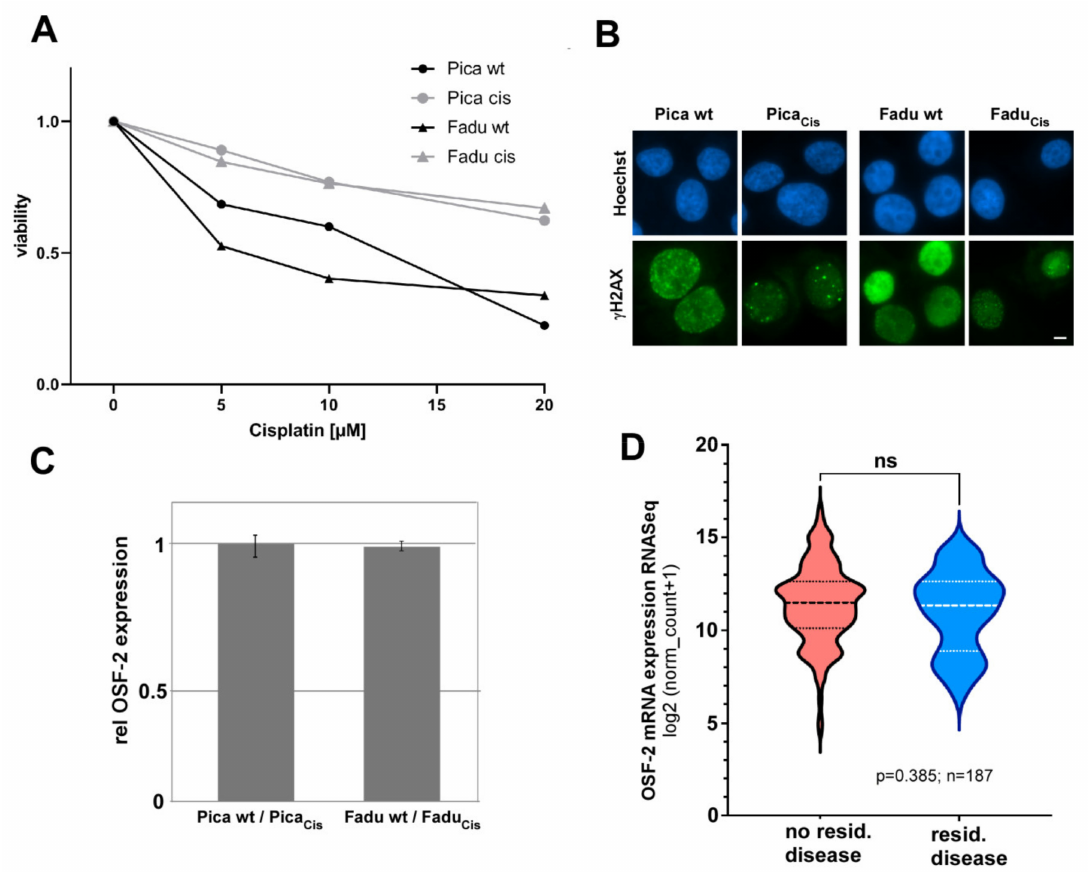
Figure 3. OSF-2 expression does not directly contribute to cisplatin therapy resistance. ( A ) Selected cisplatin-resistant Pica Cis and FaDu Cis cells (grey) are highly resistant. Cells were treated with indicated cisplatin concentrations for 48 h and viability normalized to untreated controls. ( B ) Resistant Pica Cis and FaDu Cis cells show a lower number of cisplatin-induced DNA damage foci ( γ H2AX) compared to wt Pica/FaDu cells. Cells were treated with 20 µ M cisplatin and analyzed by fluorescence microscopy after 24 h. Scale bar, 5 µ m. ( C ) OSF-2 is not overexpressed in resistant Pica Cis /FaDu Cis versus sensitive wt cells. OSF-2 expression was quantified by RNASeq transcriptomics; relative mRNA expression is shown. ( D ) OSF-2 expression does not correlate with locoregional remission status after primary therapy ( disease after curative treatment) in the TCGA HNC patient cohort. p -value and sample size ( n ) as